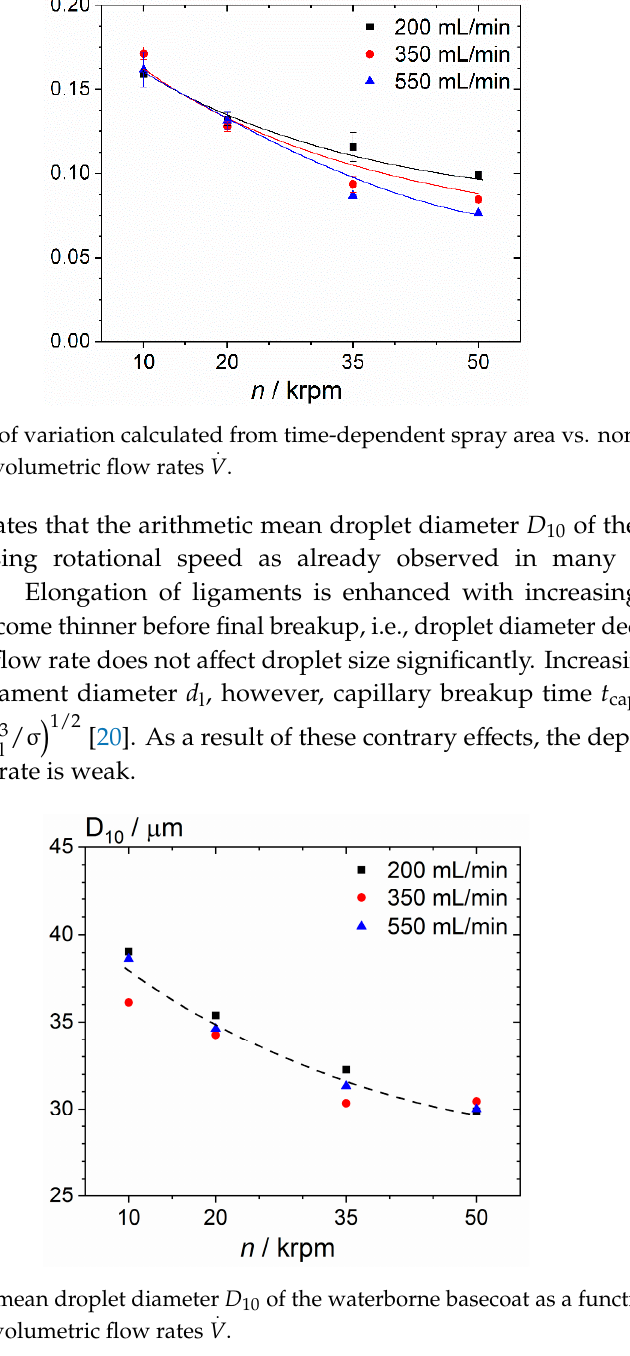
Figure 7. Coefficient of variation calculated from time-dependent spray area vs. nominal rotational speed n for different volumetric flow rates (cid:1848)(cid:4662) .